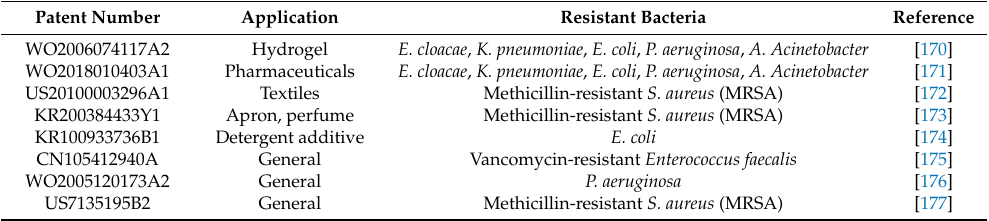
Table 4. Patents of AgNPs-based products tested against resistant bacterial